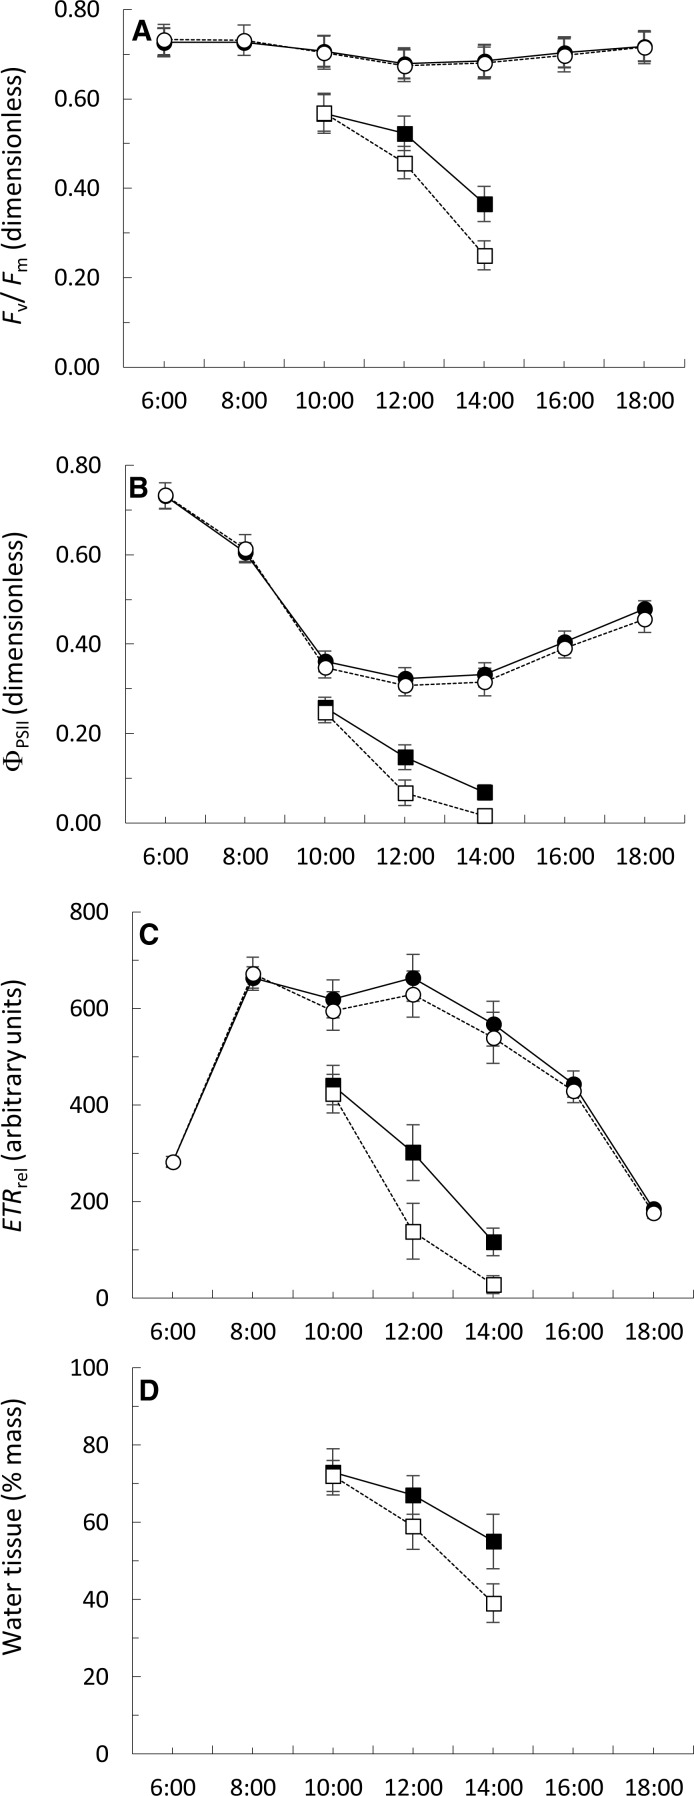
Daily course (hours:minutes, Coordinated Universal Time) of the Fv∕Fm (A), ΦPSII (B) ETRrel (C) and water tissue content (D) of Fucus guiryi from Tarifa (black symbols, continuous lines) and from Punta de Calaburras (white symbols, dotted lines) in air (squares) and water (circles).The measurements were carried out on 16th July 2011 in Tarifa, and the next day in Punta de Calaburras.